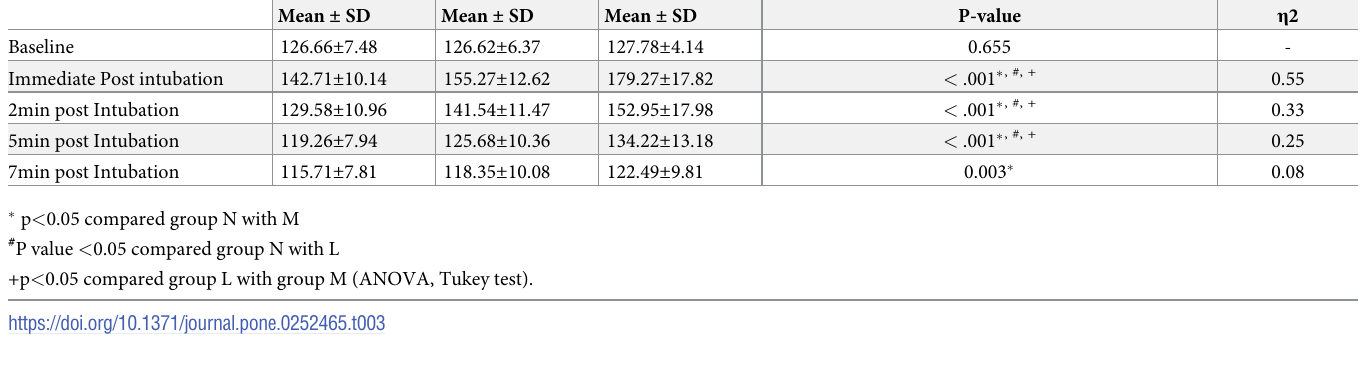
Table 3. Comparison of mean SBP among the groups and between groups at different time intervals in Zewditu Memorial Hospital, Addis Ababa, 2018/2019. Time Interval